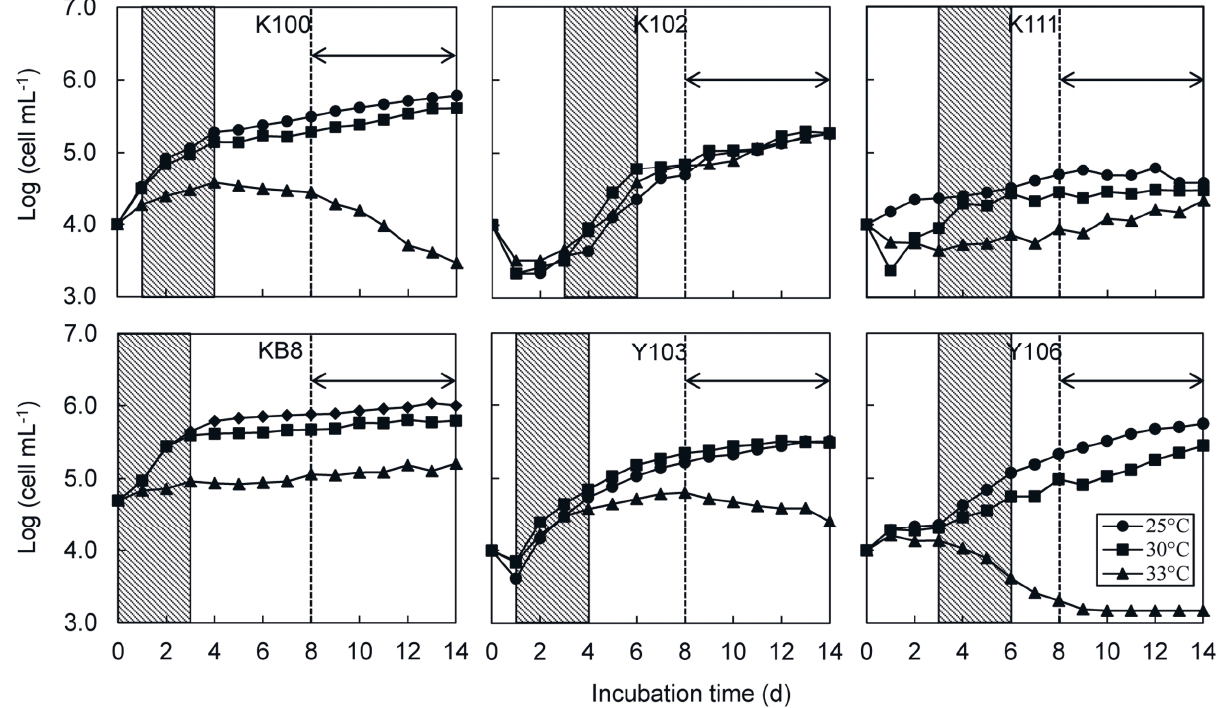
Figure 1. Growth curves of six strains of Symbiodinium at different temperatures. Changes in mean cell density ( n = 4 for each strain) are plotted over a 14-day period. Shaded areas indicates initial logarithmic phases, which were used for calculations of initial growth rate ( μ ). The arrow and dotted line indicate the growth period used for calculation of secondary growth rate ( μ s